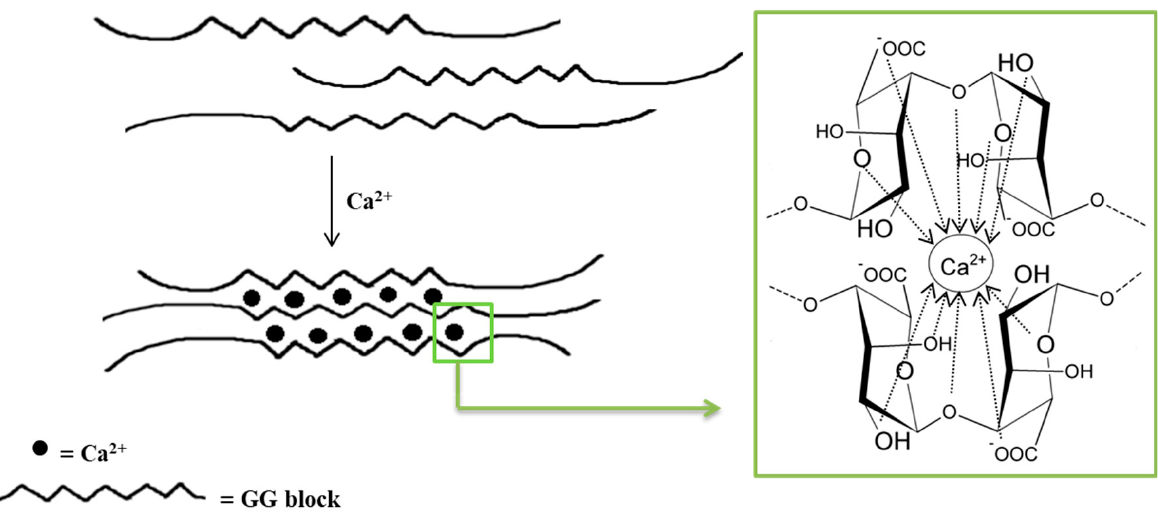
Figure 2. Scheme of an alginate gel formation by calcium cations (“egg–box”